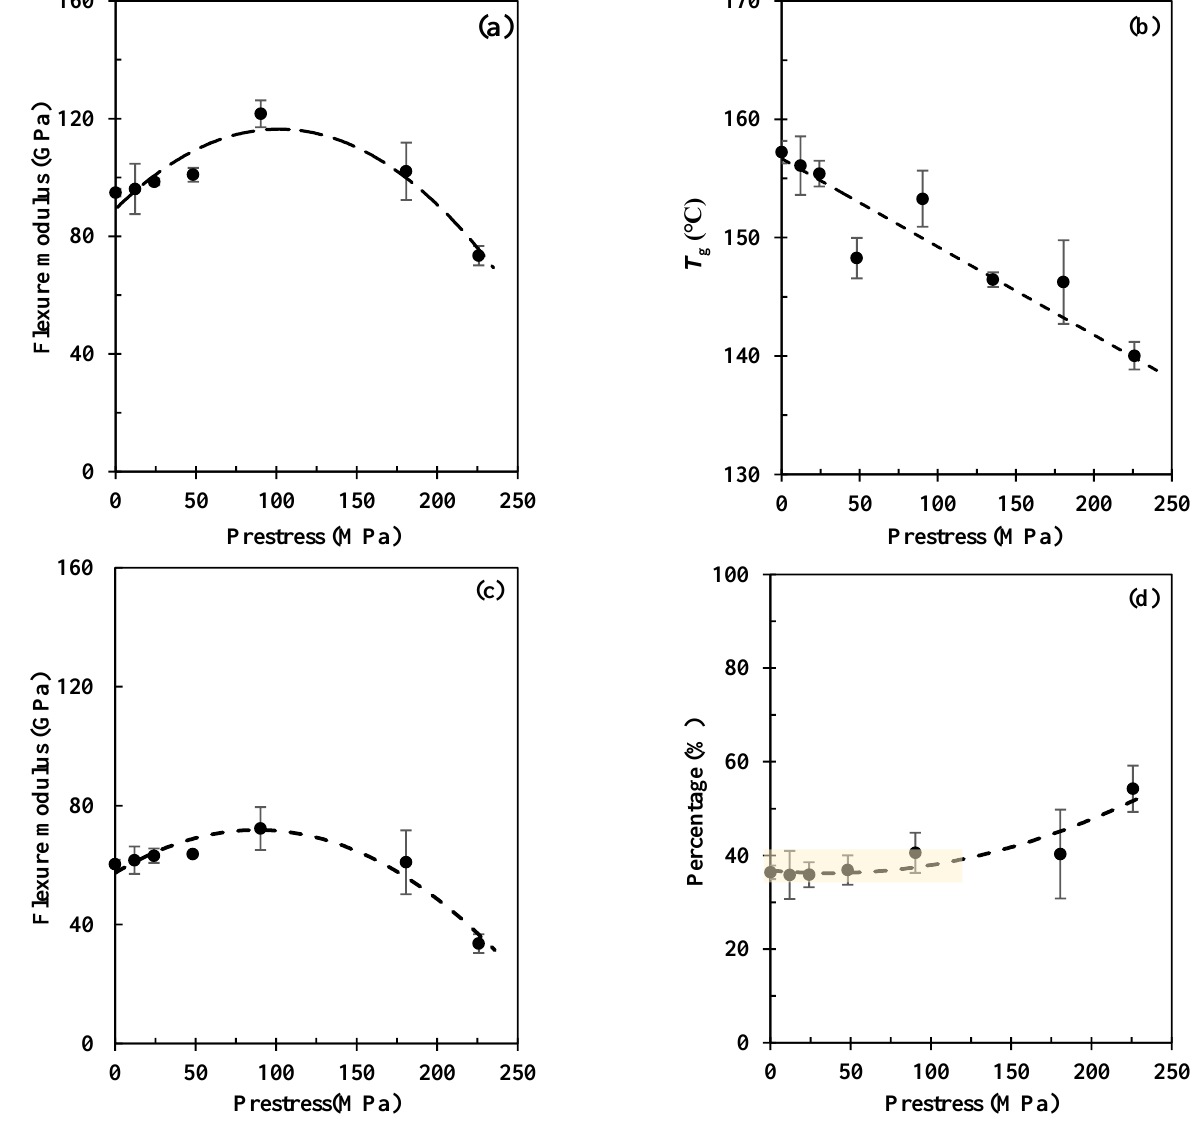
Figure 9. Effects of fibre prestressing level on ( a ) flexure modulus at 30 ◦ C (glassy region), ( b ) glass transition temperature, T g , ( c ) flexure modulus at 180 ◦ C (rubbery plateau region), and ( d ) contri- bution percentage of the thermal residual stress of the composite. Each was tested three times, and standard errors are presented by error bars.